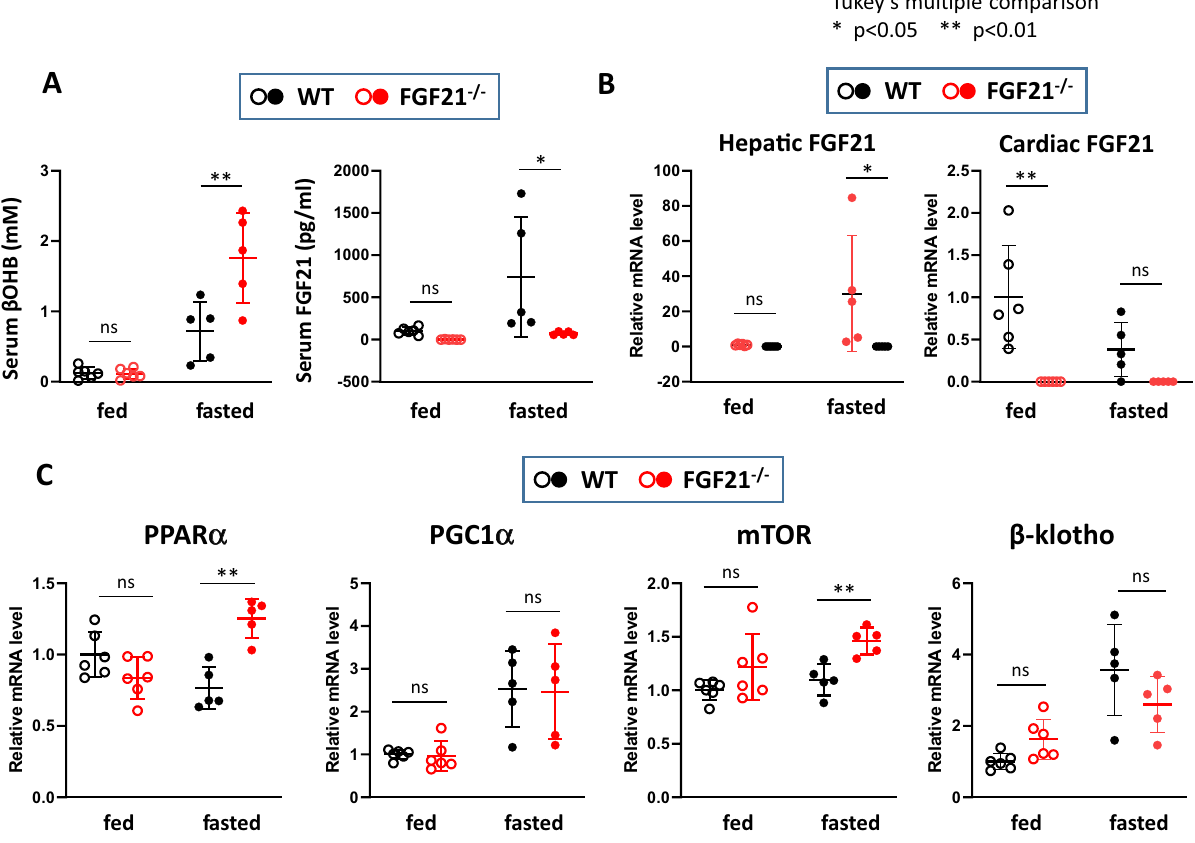
Figure 4. Effects of fasting on serum βOHB and nutrient signal-related gene expression in WT and Fgf21 −/− mice hearts. ( A ) ELISA was performed to measure the serum levels of βOHB and FGF21 in WT and Fgf21 −/− mice under either fed or 24 h-fasted conditions. ( B ) qPCR was performed to measure hepatic and cardiac FGF21 mRNAs in WT and Fgf21 −/− mice under either fed or 24 h-fasted conditions. ( C ) qPCR was performed to measure PPRAα, PGC1α, mTOR, and β-klotho mRNAs in WT and Fgf21 −/− mice under either fed or 24 h-fasted conditions. Data are mean ± SD (n = 5–6). *p < 0.05 and **p < 0.01 vs corresponding control (WT) analyzed by one-way ANOVA followed by Tukey correction for multiple